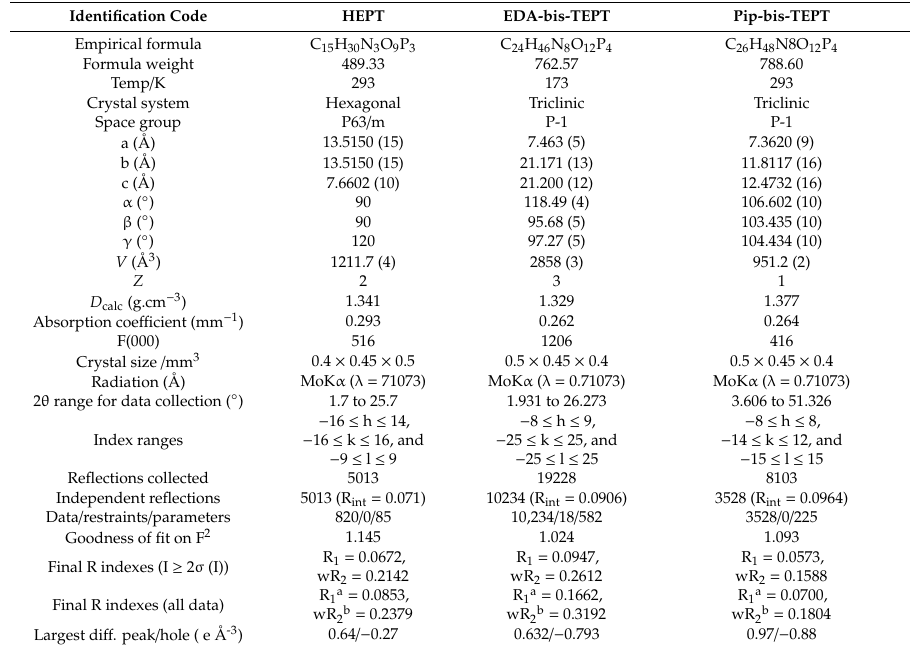
Table 4. Crystal data and structure refinement of the synthesized